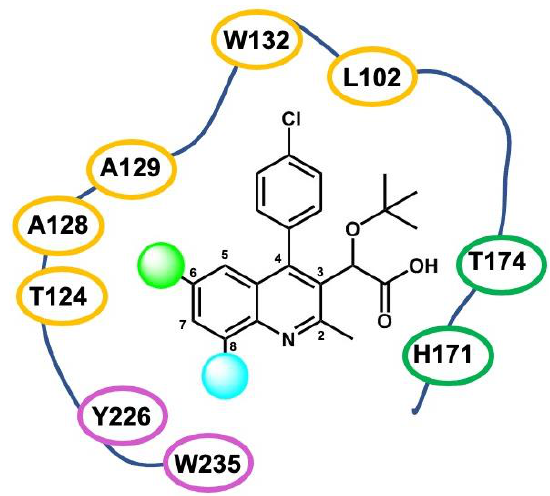
Figure 1. Representation of the quinoline scaffold within the integrase binding domain (IBD) pocket. The pocket space is defined with the green, magenta, and yellow segments which denote the individual monomeric units of the integrase multimer.